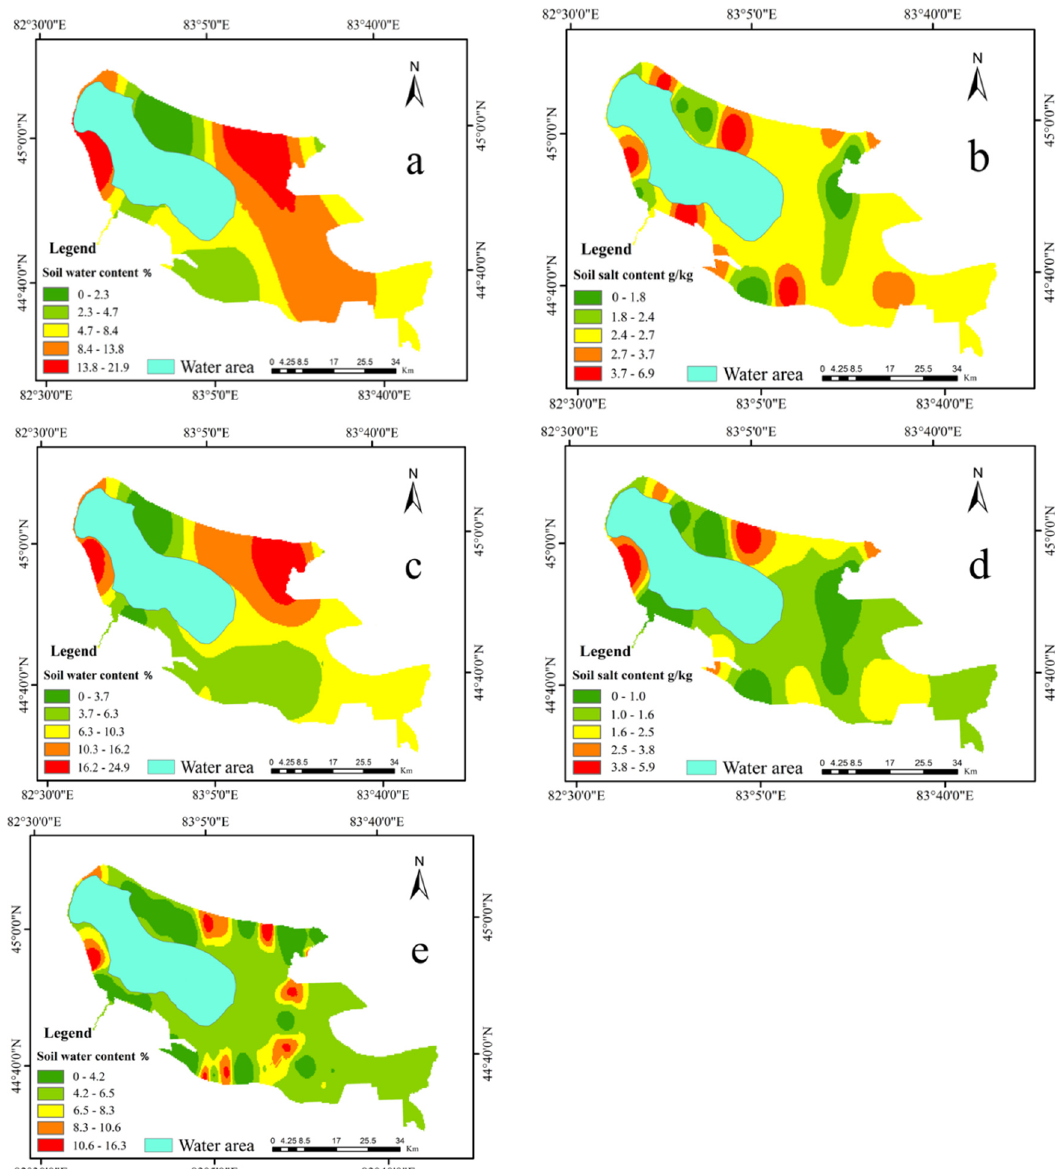
Figure 4. Data of salinization risk factors obtained by GIS interpolation in wet season: ( a ) spatial distribution of the SH_wat risk factors; ( b ) spatial distribution of the SH_sal risk factors; ( c ) spatial distribution of the D_wat risk factors; ( d ) spatial distribution of the D_sal risk factors; and ( e ) spatial distribution of the S_wat risk factors.